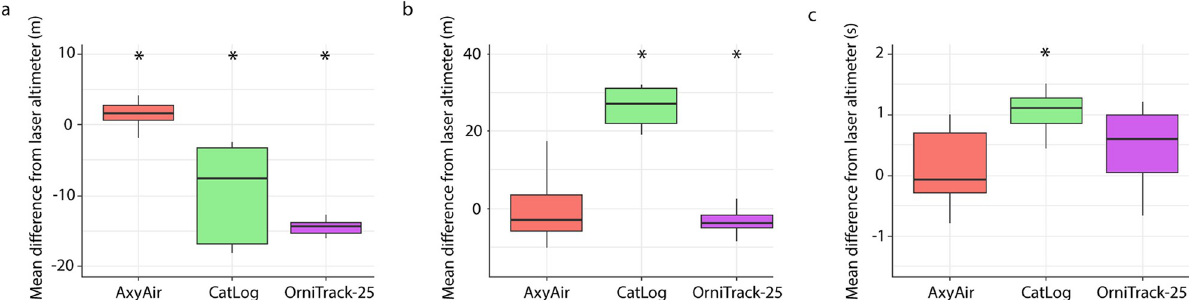
Fig 6. Mean difference between each device and the laser altimeter in a) amplitude (m); b) altitude of wave peak (m); c) wave period (s). Asterisks represent significant differences from the laser altimeter ( α �